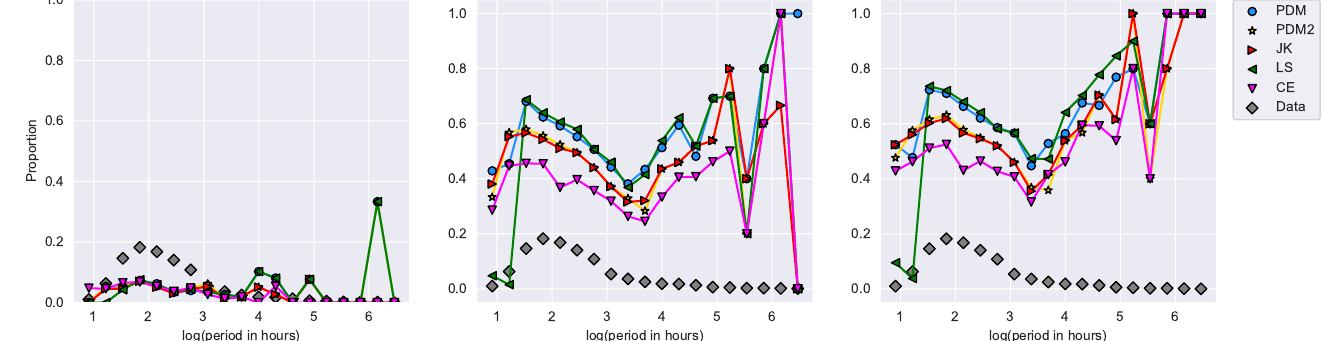
Figure 10. The comparison of different period finding algorithms considering the different reported periods for the step size of 10 − 6 h − 1 of frequency searching. The criterion for comparison is the proportion of asteroids having a successful periodic recovery. From left to right, the three plots are for different δφ max = 85/50,850/50 and 8500/50. The gray diamonds indicate the proportion of asteroids at the corresponding reported period in our data set.